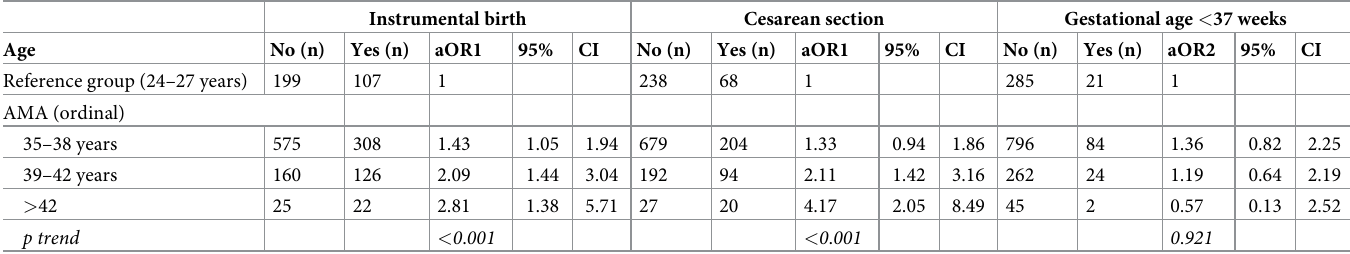
Table 5. Associations between AMA categorized in an ordinal manner and the risk of instrumental birth, cesarean section and premature birth ( < 37